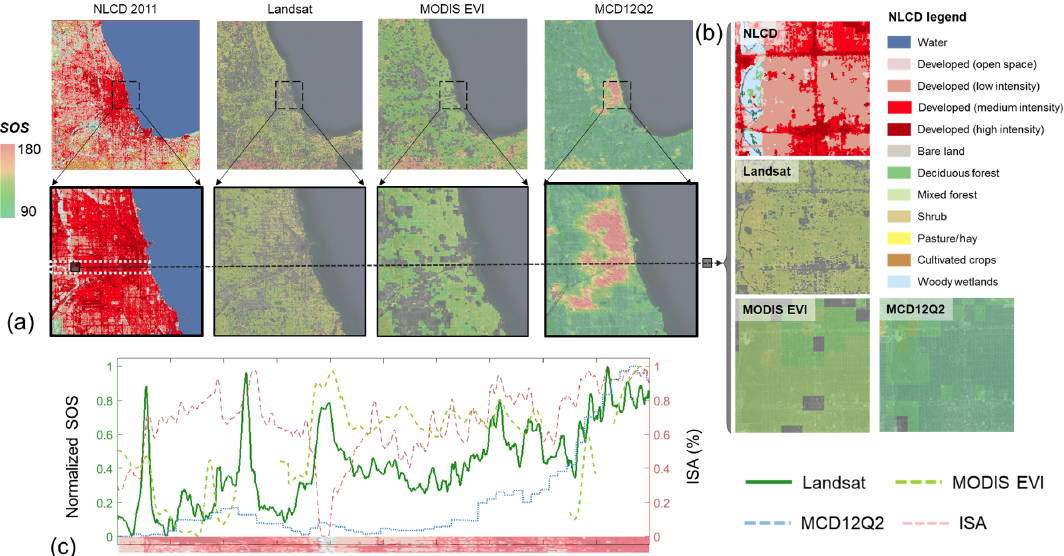
Figure 9. Spatial patterns of the mean start of season (SOS) (2001–2014) derived from Landsat, the Moderate Resolution Imaging Spectroradiometer (MODIS) enhanced vegetation index (EVI), and MCD12Q2 and the land cover from the national land cover database (NLCD) (2011) in the Chicago metropolitan area (a) . Enlarged views (b) at the location of the black square in (a) . Change of normalized SOS and impervious surface area (ISA) (c) along the white rectangle in (a) (from left to right). Pixels without good fitting performance (i.e., the correlation coefficient is lower than 0.85) were removed in the derived SOS from Landsat and MODIS EVI.